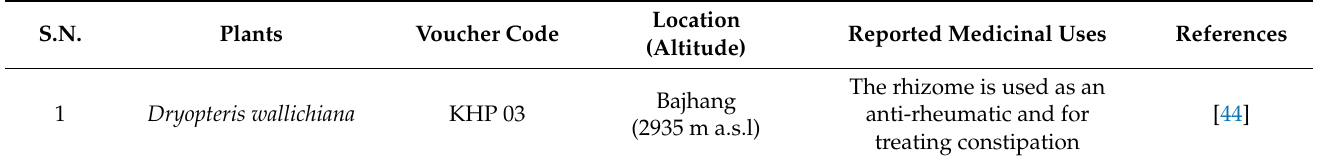
Table 1. Screening of crude extracts (5 mg/mL) of ethnomedicinal plants based on S1-RBD assay with their reported medicinal